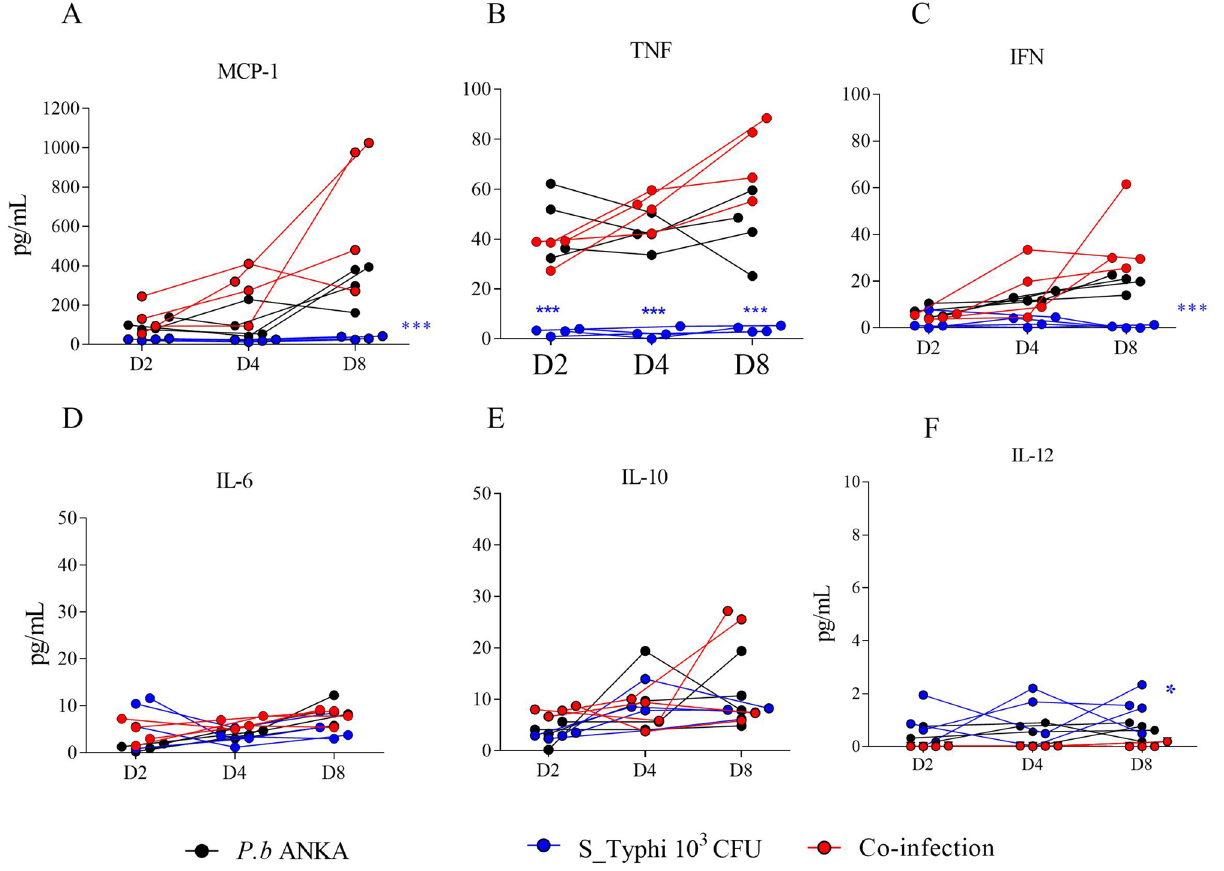
Figure 2. Inflammation response on days D2, D4 and D8 in the coinfection model. The plasma of four animals was sampled for the determination of inflammation response using a cytometric bead array (Mouse Inflammation CBA Kit; BD-Biosciences/USA). ( A ) MCP-1; ( B ) TNFα; ( C ) IFNγ; ( D ) IL-6; ( E ) IL-10 and ( F ) IL-12. The data for cytokines and chemokines are grouped by mean and standard deviation in a spreadsheet using the GraphPad Prism program (version 7). Asterisks: level of significance of * p < 0.05, ** p < 0.005 and *** p <